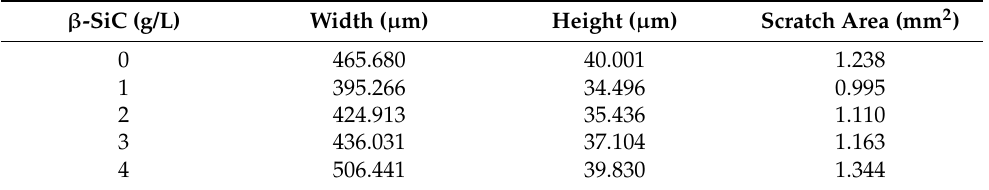
Figure 8. Wear and scratch surface morphology of the composite coating with different β -SiC concentrations prepared on the spindle. Section parameters of wear scars on the composite coating with